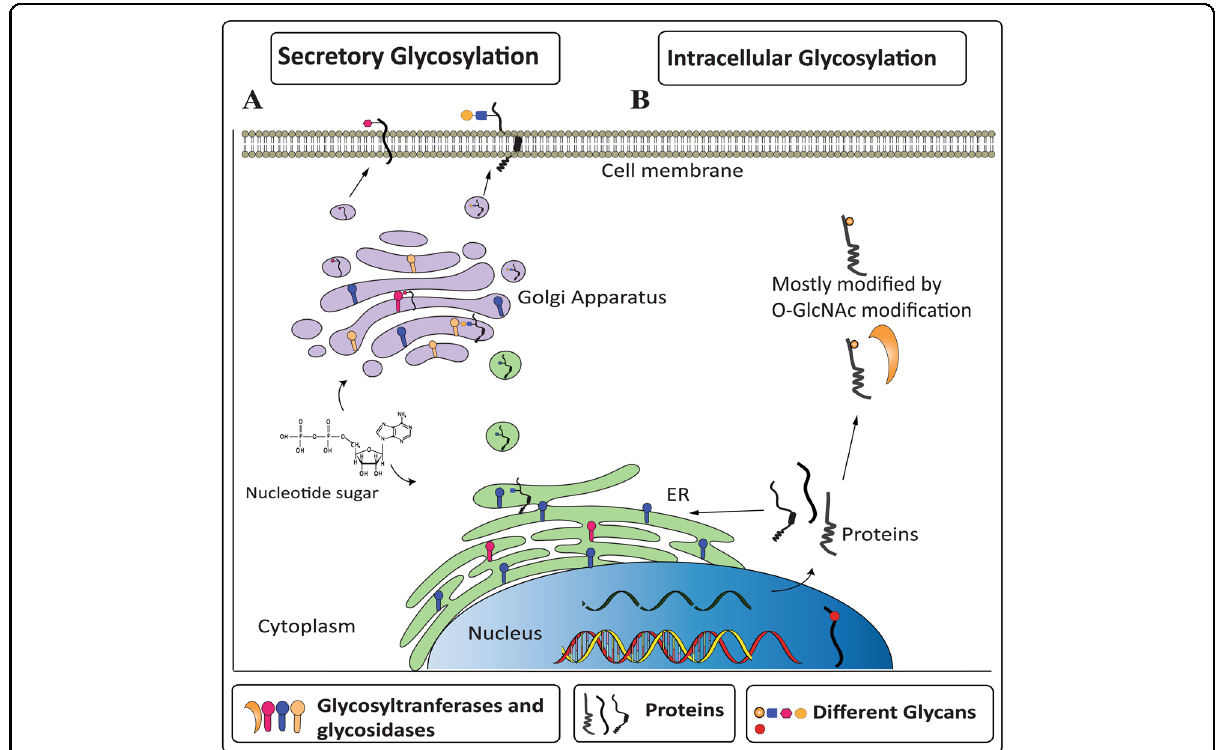
Fig. 1 Cellular regulation and representation of glycans. Depending on the intracellular compartments, mechanisms altering the intracellular location of glycosyltransferases and glycosidases can in fl uence and regulate glycans mod fi cation. A Secretory glycosylation occurs mainly in the ER and Golgi apparatus for secreted or transmembrane proteins where glycosyltransferases add and extend glycan modi fi cation in an ordered sequential manner. Cellular receptors and secretory proteins are transported to the cell surface and extracellular space, respectively. B Intracellular glycosylation involves the addition of glycans by OGT to proteins that reside mainly in the cytoplasm and nucleus. This modi fi cation of a Ser/Thr residue has a short lifetime and is cleaved by OGA, providing a target site for the second same modi fi cation or phosphorylation of